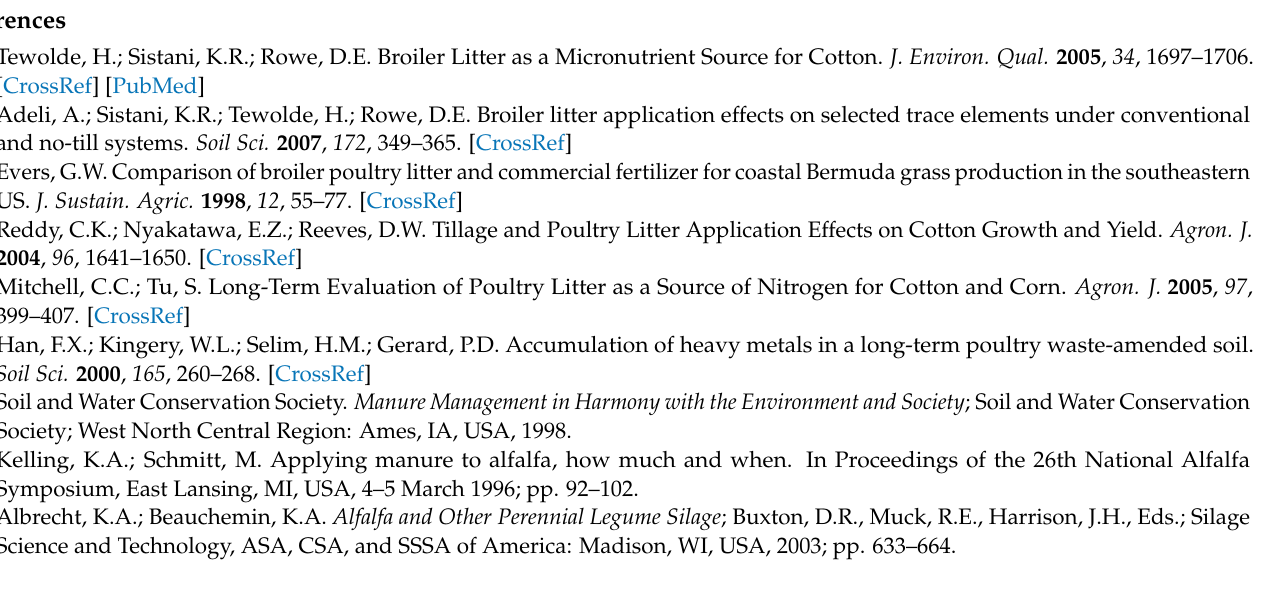
two years. Figure S1: Average monthly precipitation at the experimental site for 2017 and 2018, Figure S2: Daily average monthly air temperature at the experimental site for 2017 and 2018, Figure S3: Soil moisture levels at 5 cm depth in the experimental site for 2017 and 2018, Figure S4: Soil temperatures at 5 cm depth in the experimental site for 2017 and